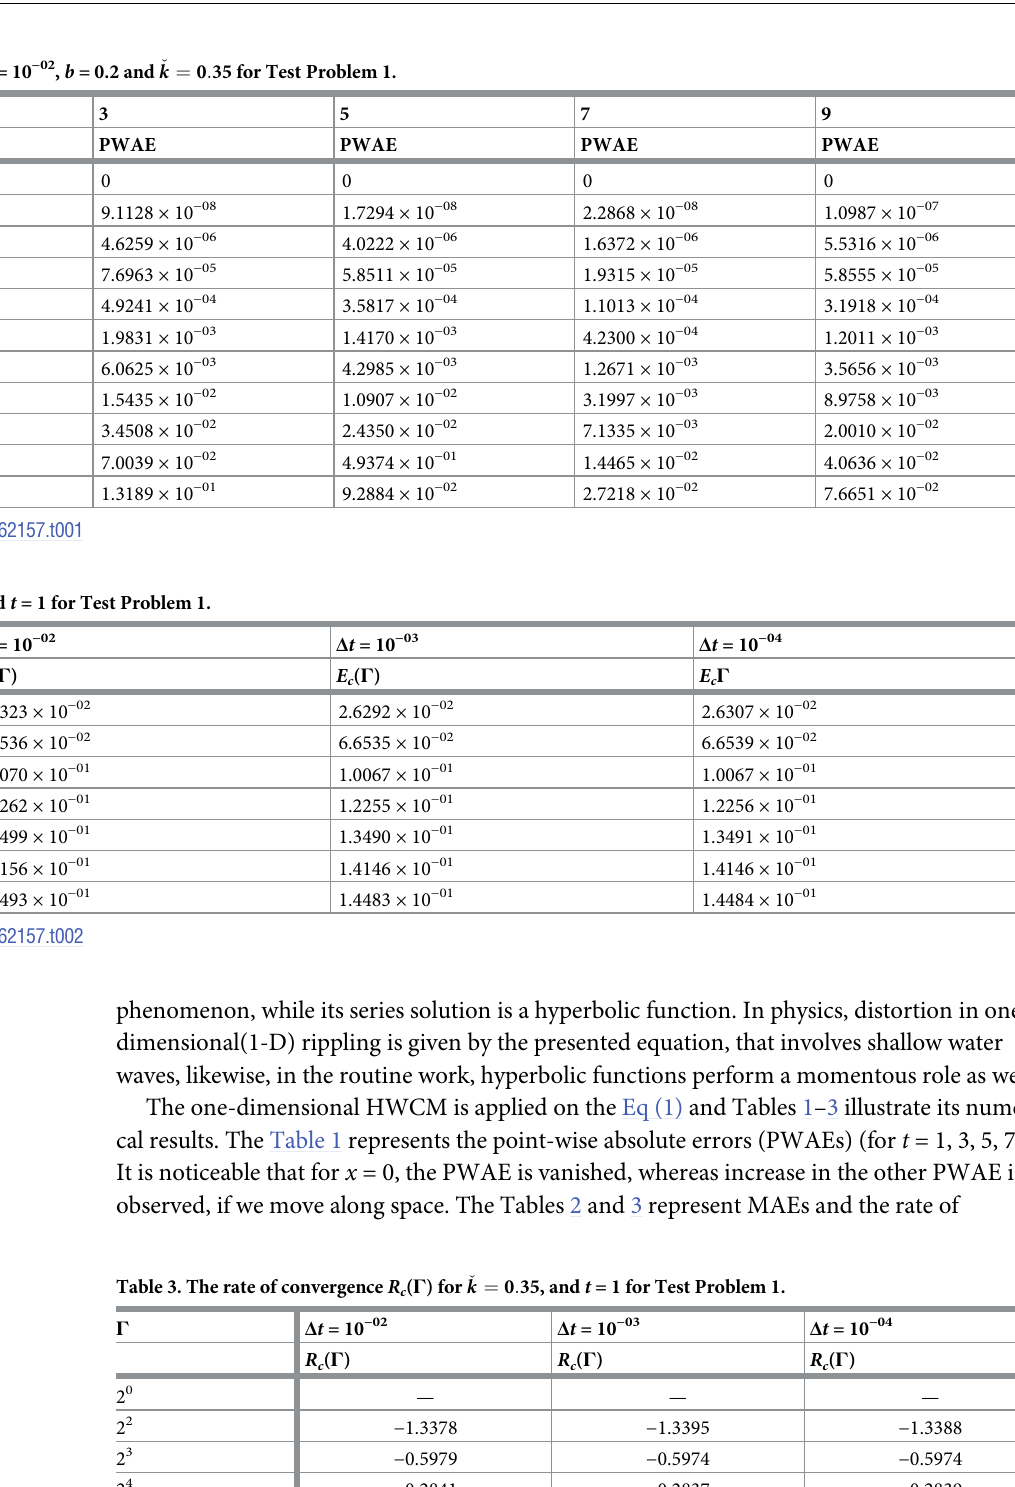
Table 3. The rate of convergence R